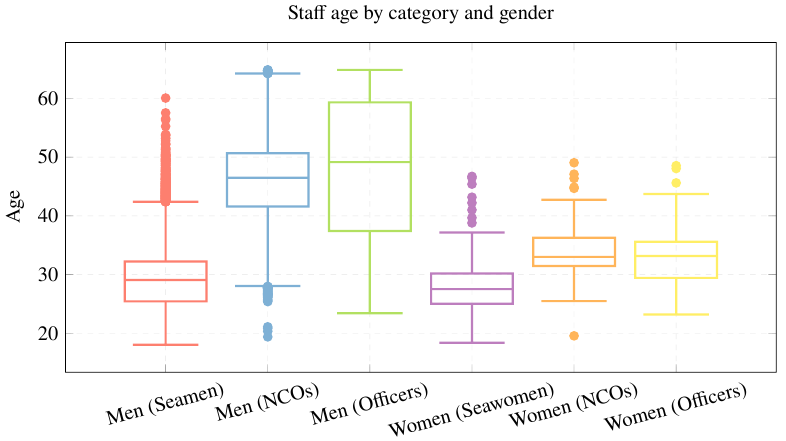
Figure 1. Spanish navy staff age by category and gender in 2007